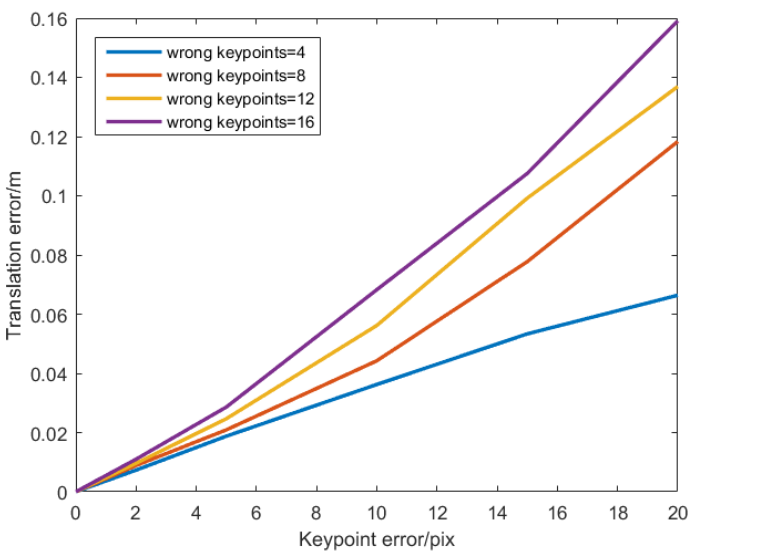
Figure 2. Errors in the determination of the keypoints’ location affects the result of pose